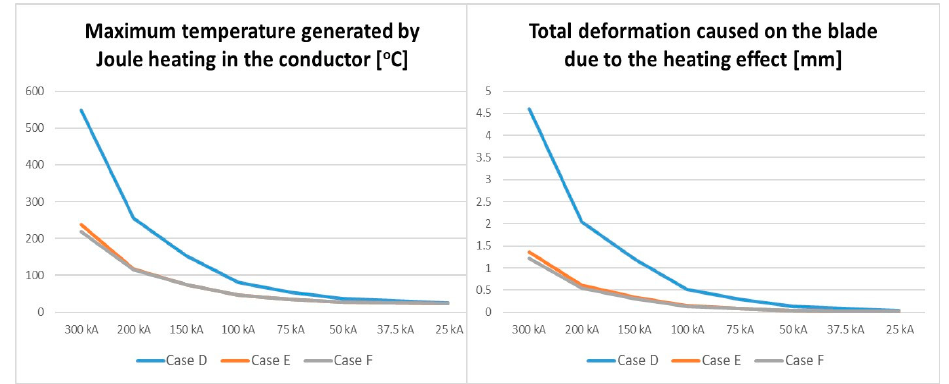
Figure 8. Maximum temperature ( left ) and total deformation of the blade ( right ) for the hybrid case